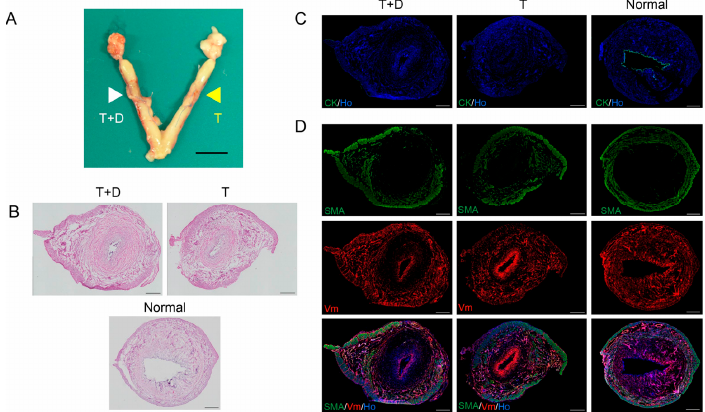
Figure 4. In vivo regeneration of the endometrium, following the placement of a silicone tube alone or a tube-loaded DES (T+D) in rats. ( A ) Representative image of the uterus excised from the rat treated for one month, showing that each horn treated with T+D (white arrowhead) or T (yellow arrowhead) was grossly normal. ( B – D ) Uterine horn that underwent no treatment (Normal) or the indicated treatment was cross-sectioned and subjected to H&E staining ( B ) or immunofluorescence staining using antibodies against CK ( C ), SMA (( D ), upper panels), and Vm (( D ), middle panels). Nuclei were stained with Hoechst (Ho). Scale bars, 500 µm.